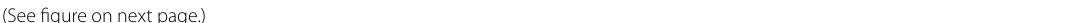
(See figure on next page.) Fig. 3 Calculated past temperature changes at the lower and upper depth limits of equivalent climate change surface air boundary layer (top), equivalent climate change waters surface boundary layer (middle), and equivalent climate change land surface boundary layer (bottom), and the temperature change forecast as well as their observed temperature anomalies under scenario